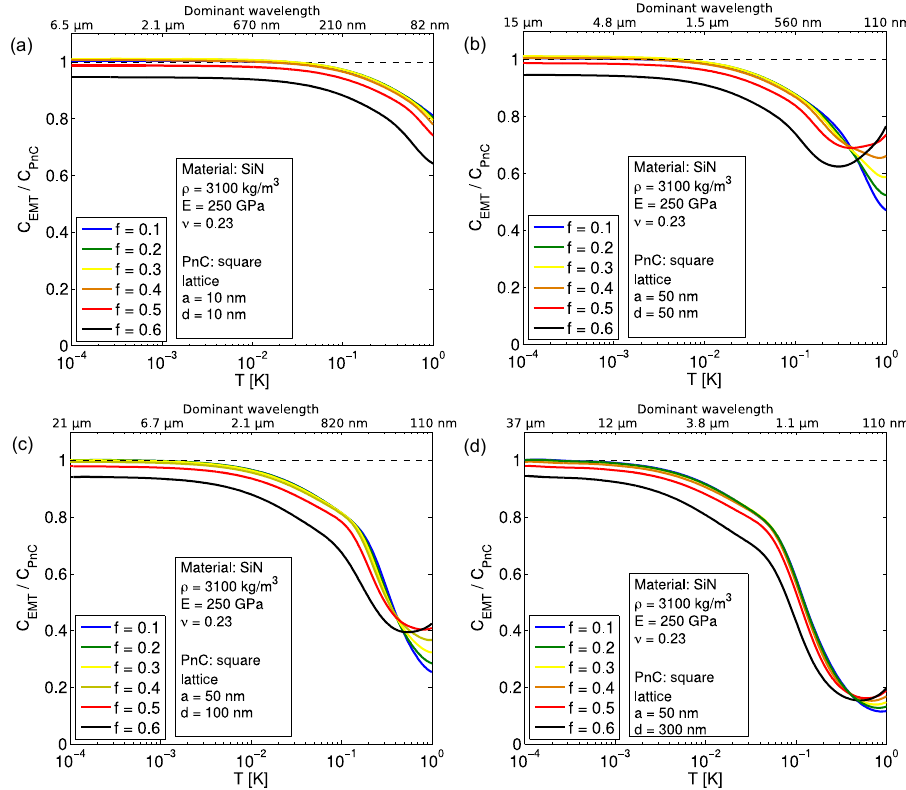
Fig. 6 Relative error of the effective medium theory. The plots show the ratio of the EMT heat capacity ( C EMT ) with the numerically calculated exact speci fi c heat capacity C PnC , for SiN phononic crystal plates (PnC) of varying lattice constants a and thicknesses d [ a a = 10 nm, d = 10 nm; b a = 50 nm, d